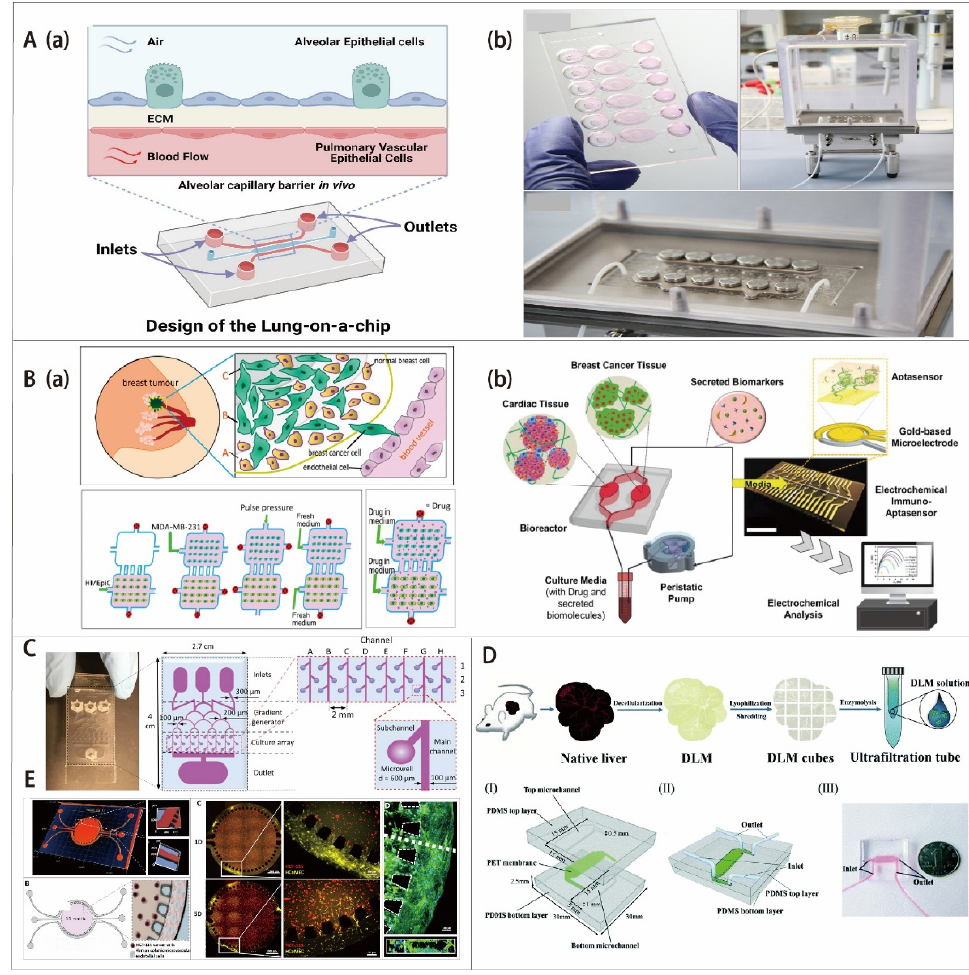
Figure 5. ( A ) Design and model of lung-on-a-chip. ( a ) Cross-sectional view of a lung-on-a-chip microfluidic model with two distinct channels separated by a thin porous membrane . Reprinted with permission from Ref. [190]. Copyright 2022, Elsevier. ( b ) The model of lung-on-a-chip comprising liquid interface for inhalation assays. Reprinted with permission from Ref. [185]. Copyright 2019,